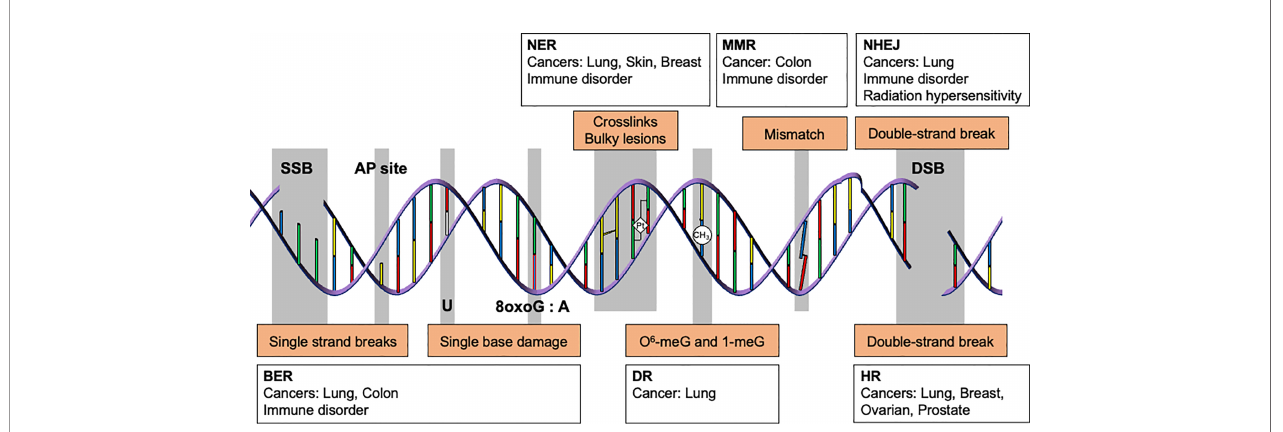
FIGURE 1 | DNA repair pathways and their association with cancer and immune disorders. Genome integrity is maintained by multiple DNA repair pathways. Depending on the type of DNA damage, speci fi c subsets of DNA repair proteins recognize and repair the damage. For instance, single strand breaks, abasic sites, and single base lesions are primarily repaired by base excision repair (BER). Some types of alkylation damage, such as O 6 -methylguanine and 1-methylguanine, are repaired by direct reversal (DR). Intra-strand crosslinks and bulky lesions are repaired by nucleotide excision repair (NER). Mismatched bases are repaired by mismatch repair (MMR), whereas double strand breaks are resolved by homologous recombination (HR) or non-homologous end joining (NHEJ). Unrepaired DNA lesions may give rise to somatic mutations and cancer. De fi ciency in BER, NER, MMR, and NHEJ is also associated with immunode fi ciency, which increases cancer